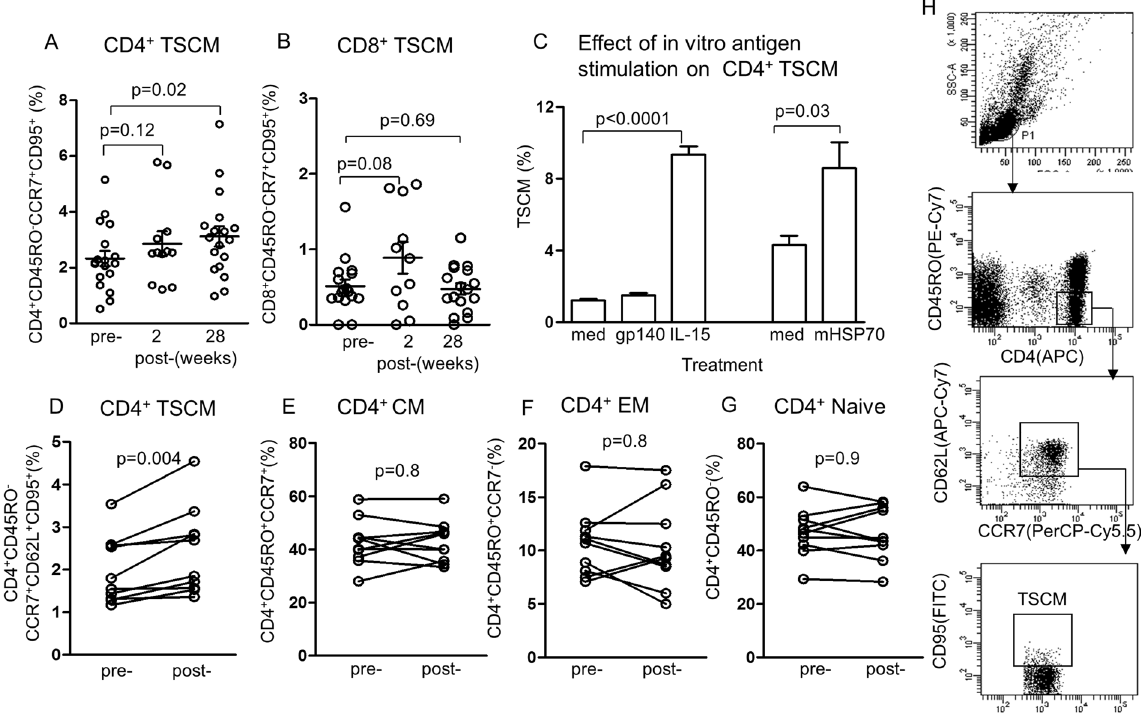
Figure 1. Identification of TSCM CD45RO − CCR7 + CD95 + CD4 + and CD8 + T cells. ( A ) CD4 + TSCM and ( B ) CD8 + TSCM cells pre- immunization, 2 and 28 weeks after the last immunization (n = 12–18), all from different immunized subjects. ( C ) The specificity of TSCM was examined by in vitro stimulation with HIVgp140 and compared with recombinant IL-15 and microbial (m) HSP70. ( D ) Shows significant increase in CD4 + TSCM 28 weeks after the last immunization in the vaccinated cohort, but not in the CCR7 + central (CM), CCR7- effector memory (EM) or naïve CD4 + T cells (n = 10 in each group, ( E , F , G ). ( H ) Identification of TSCM and